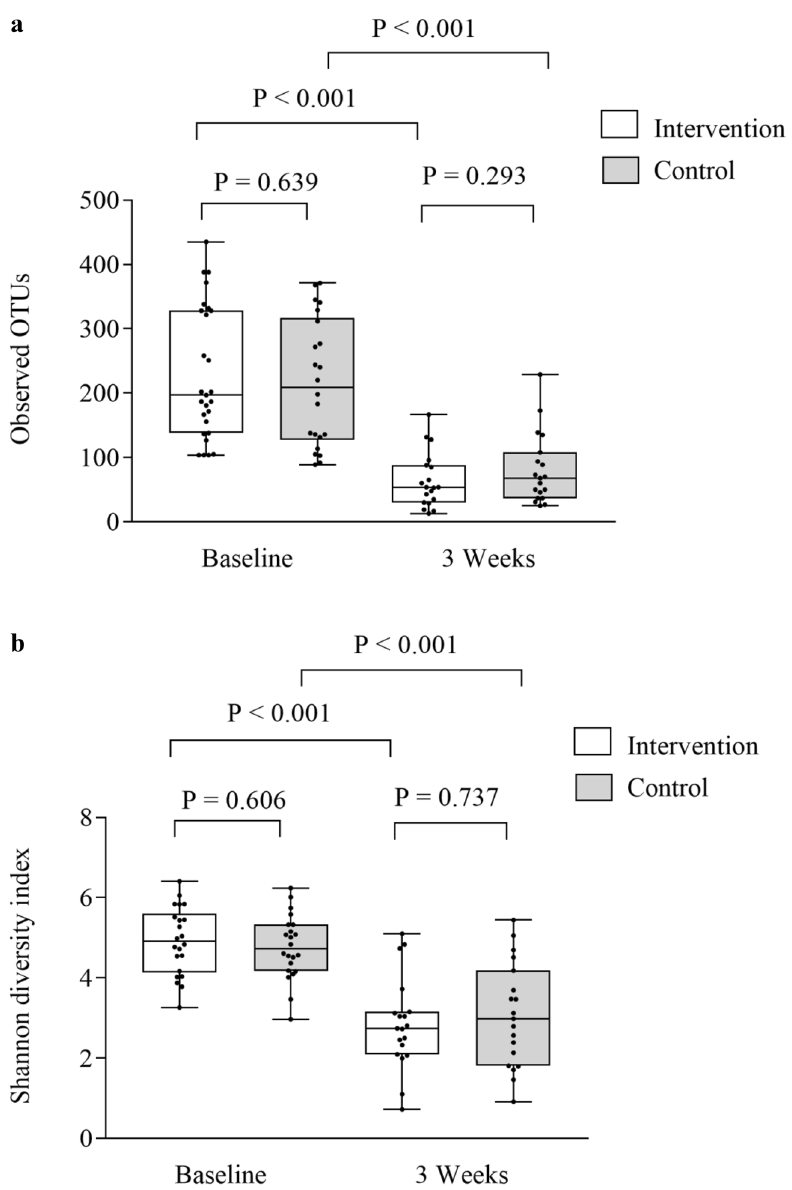
Figure 1. Gut microbial diversity and the intervention and control group at baseline and 3 weeks. ( a ) Observed operational taxonomic units (OTUs) and groups, ( b ) Shannon diversity index and groups. Data are observed operational taxonomic units (OTUs) and Shannon diversity index given as individual values (dots) and box plots (median and interquartile range) with minimum and maximum